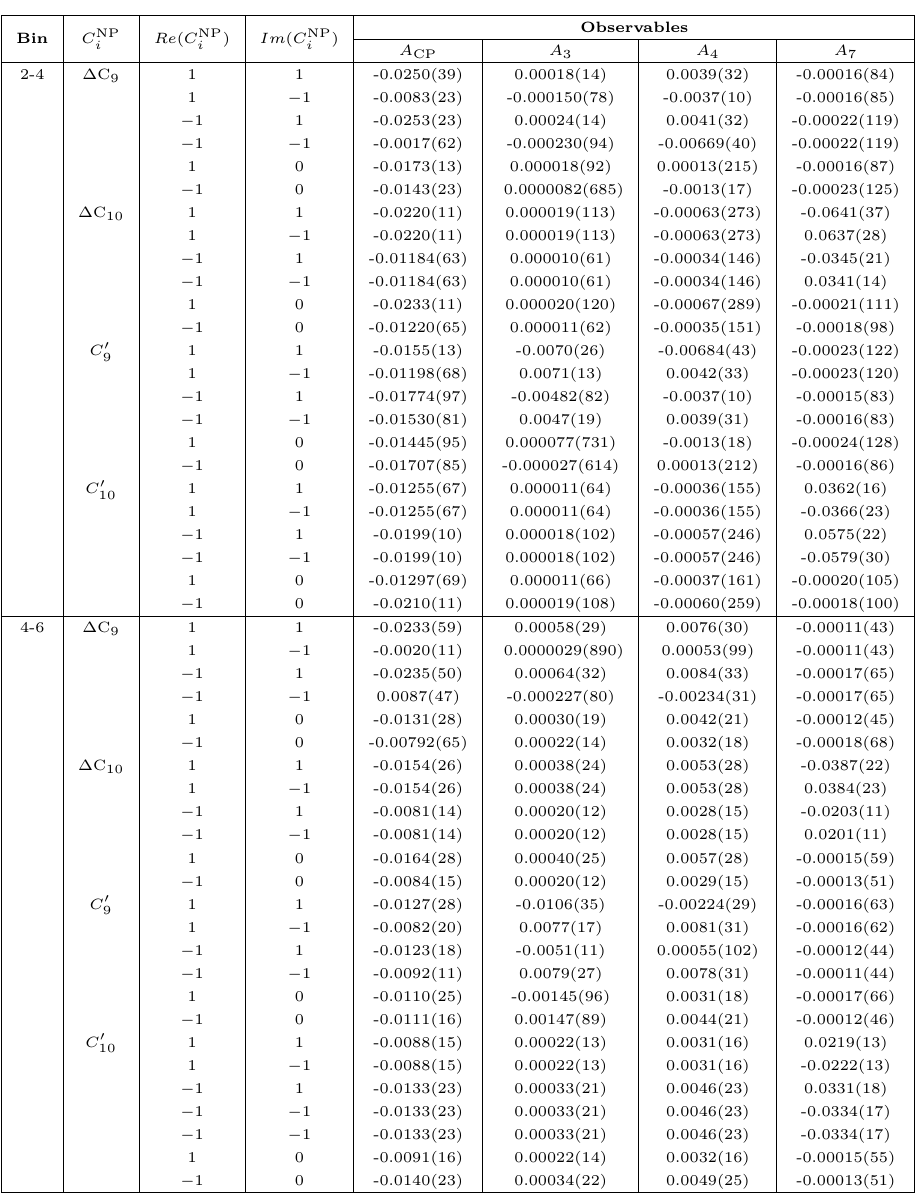
¯ B 0 ( B 0 ) → ρ 0 ll which and C 0 9 , 10 9 , 10